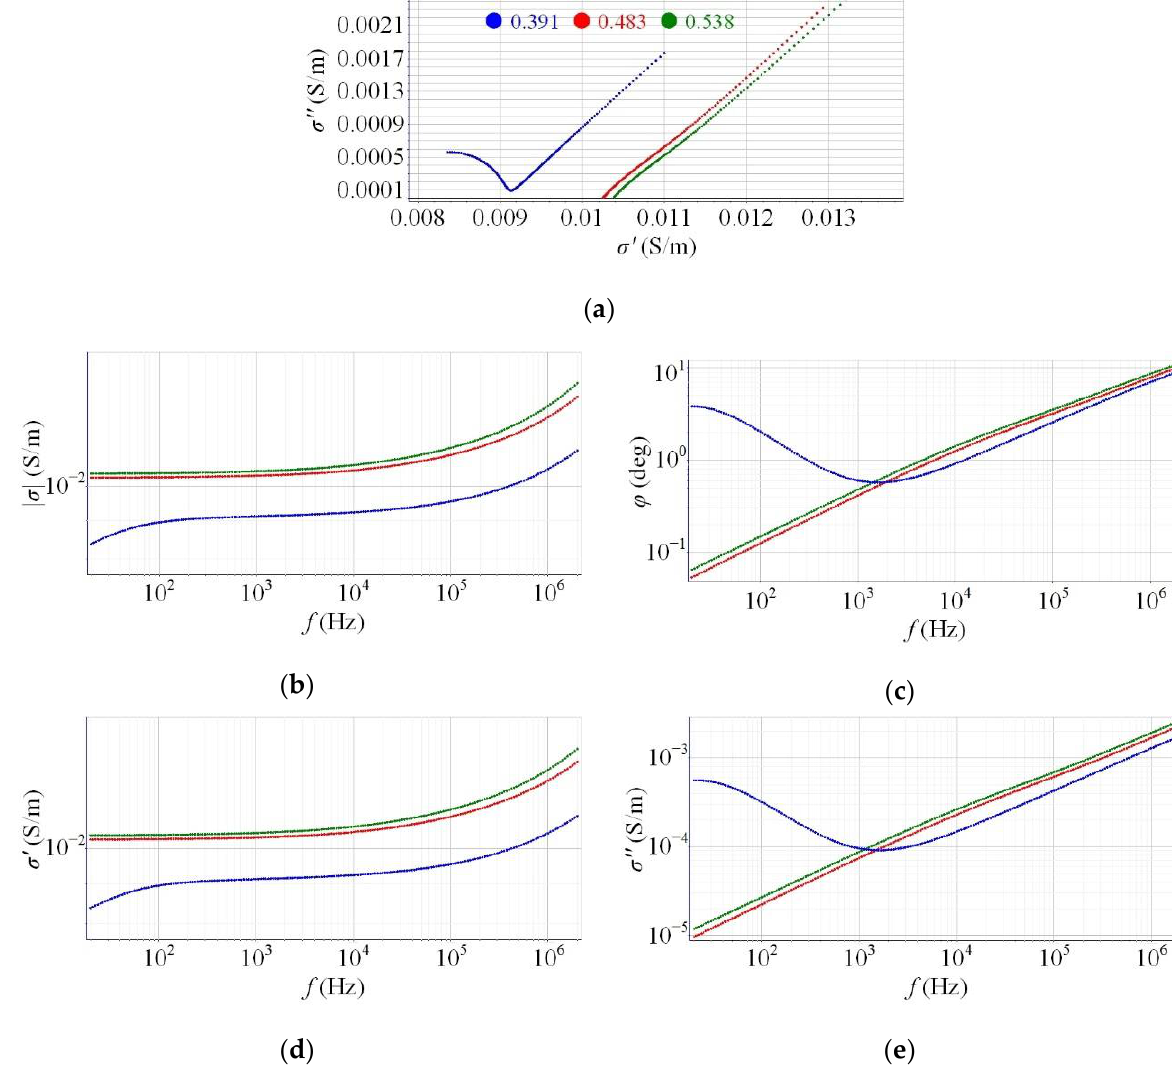
Figure 7. Impact of changes in dry density on complex conductivity of substrate. ( a ) Nyquist plots; ( b ) magnitude spectra; ( c ) Phase spectra; ( d ) in-phase conductivity spectra; ( e ) quadrature conductivity spectra. For the spectra marked by different colors, the variable dry densities are provided in ( a ), while the related volumetric water contents (Table 3) are considered to be nearly equal. The frequency range is from 20 Hz to 2 MHz.